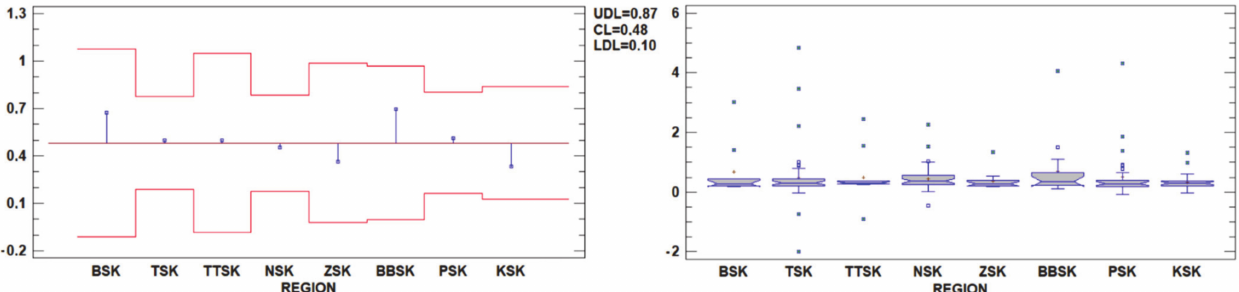
Figure 6. Comparison of the structure of results at the level of individual regions—Taffler model, businesses. Legend: BSK— Bratislava region, TSK—Trnava region, TTSK—Trenˇc í n region, NSK—Nitra region, ZSK—Žilina region, BBSK—Bansk á Bystrica region, PSK—Prešov region, KSK—Košice region; UDL—upper decision limit, CL—central line, LDL—lower decision limit.